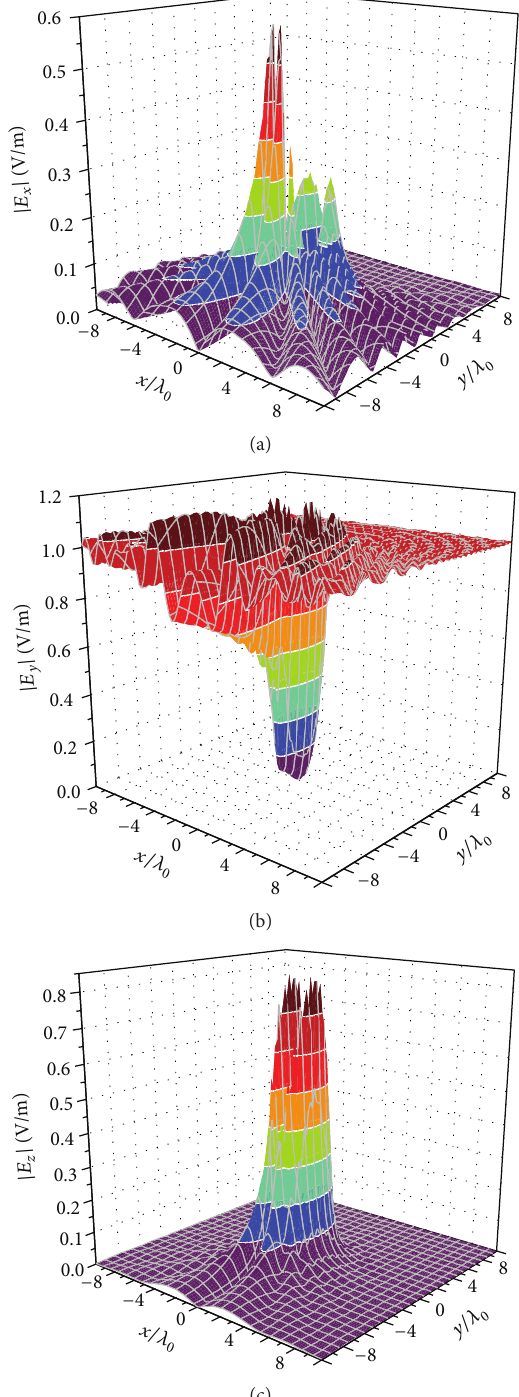
Figure 4: Magnitude of the total electric field 𝜆 0 /1000 above the Almond: (a) 𝑥 -, (b) 𝑦 -, and (c) 𝑧 -component of the electric field. Characteristics of the incident field: 𝐸 0 = 1 V/m, 𝜃 𝑖 = 90 ∘ , 𝜑 𝑖 = 0 ∘ , and polarization angle 𝛼 = 90 ∘